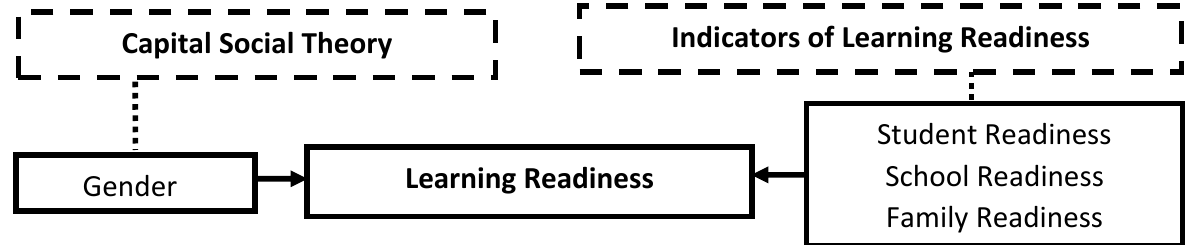
Figure 1. Conceptual Framework (Modified from Daza, 2016; UNICEF,